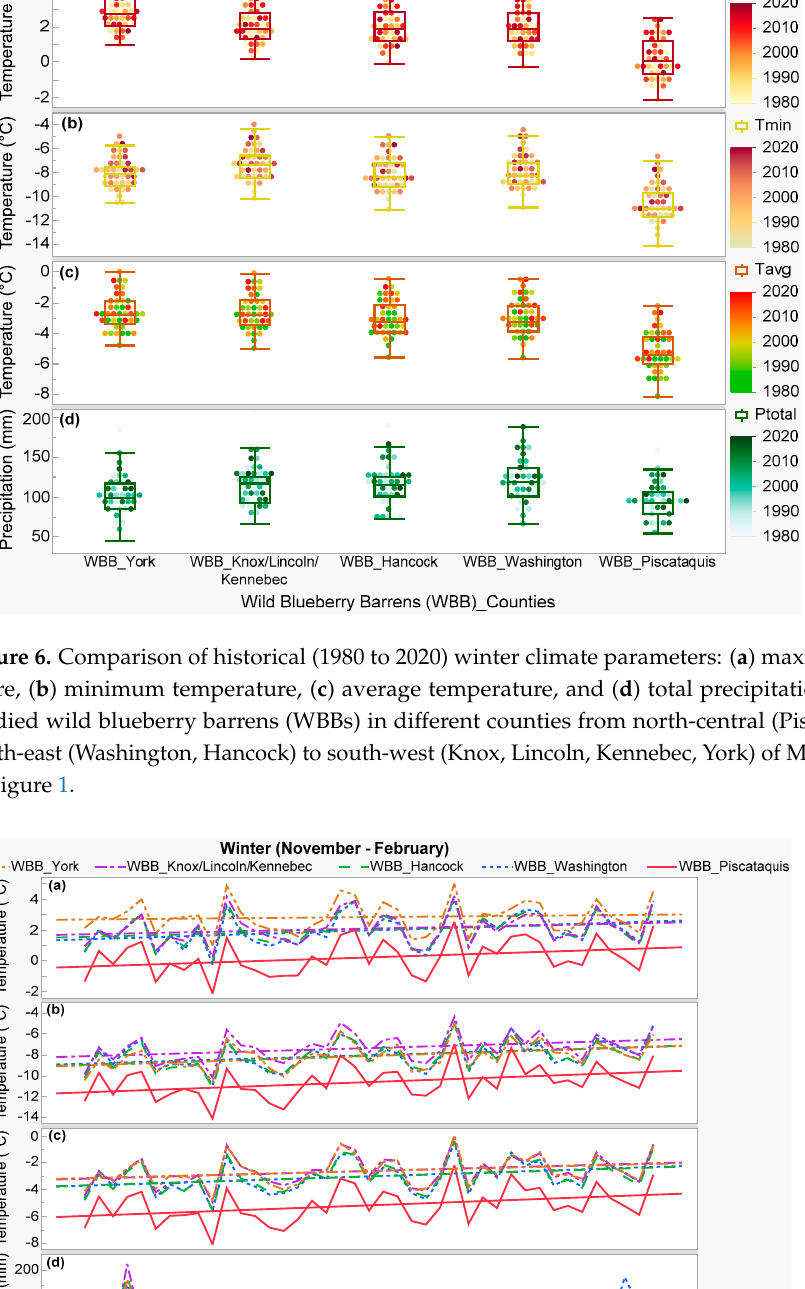
Figure 5. Historical (1980 to 2020) changes with fitted linear regression trendlines for the summer climate parameters: ( a ) maximum temperature, ( b ) minimum temperature, ( c ) average temperature, and ( d ) total precipitation, throughout the studied wild blueberry barrens (WBBs) in different counties from north-central (Piscataquis) and north-east (Washington, Hancock) to south-west (Knox, Lincoln, Kennebec, York) of Maine as shown in Figure 1.